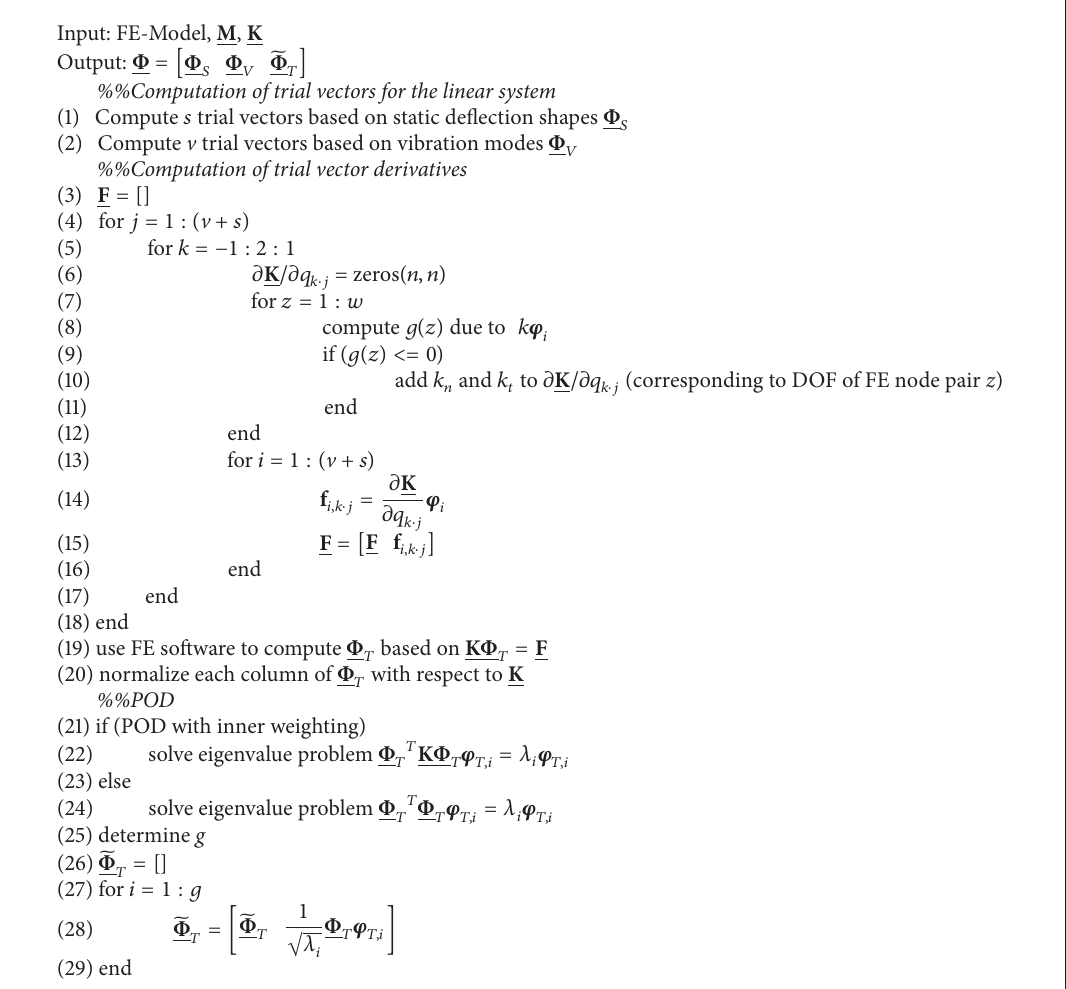
Algorithm 2: Construction of reduction base for jointed structures.